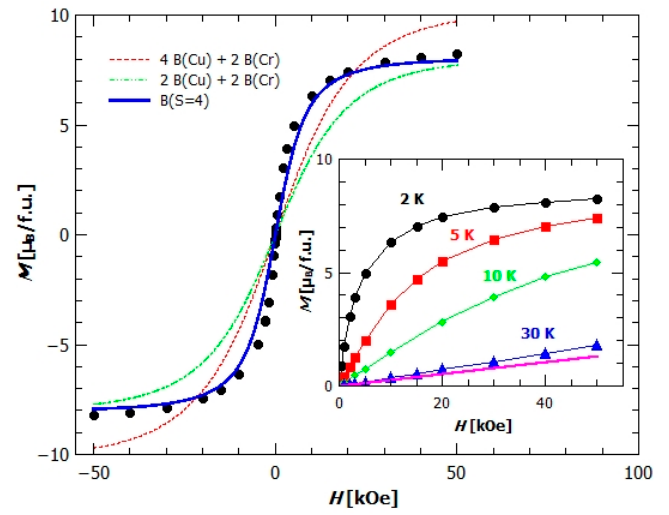
Figure 10. Field dependence of magnetization of compound 2 , with plotted Brillouin functions B for different possible situations (explained in text). Inset: field dependence of magnetization at different temperatures, with the pink line representing the B function for independent spins in the formula unit.